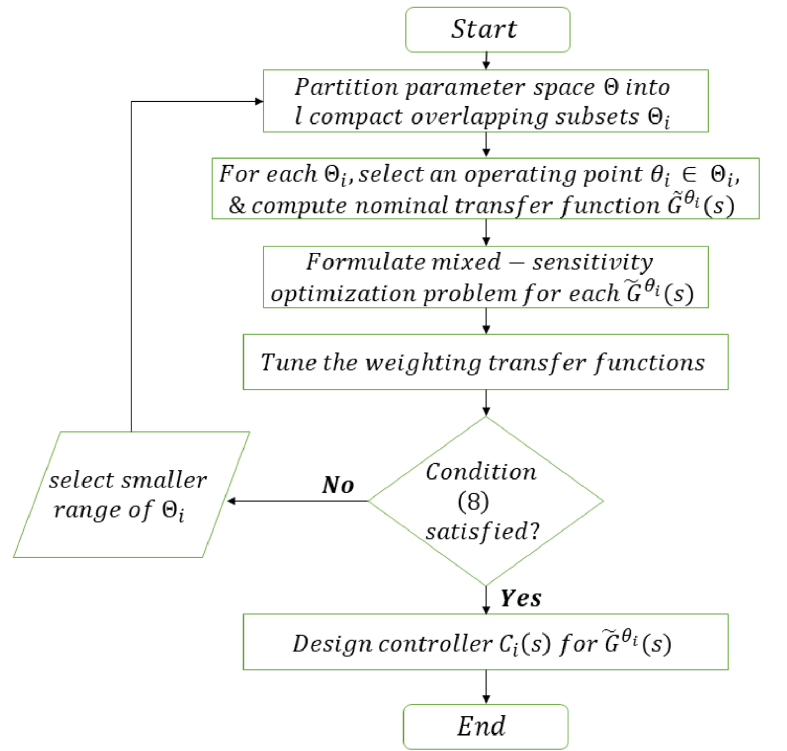
Fig 5. Flowchart of algorithm for design of robust switching controllers.